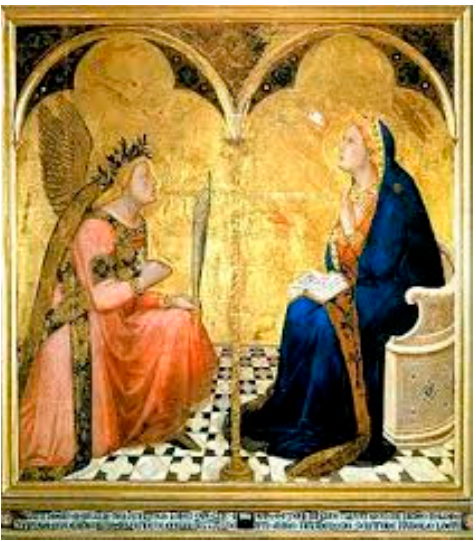
Figure 4. A. Lorenzetti, “Annunciazione”, 1344.